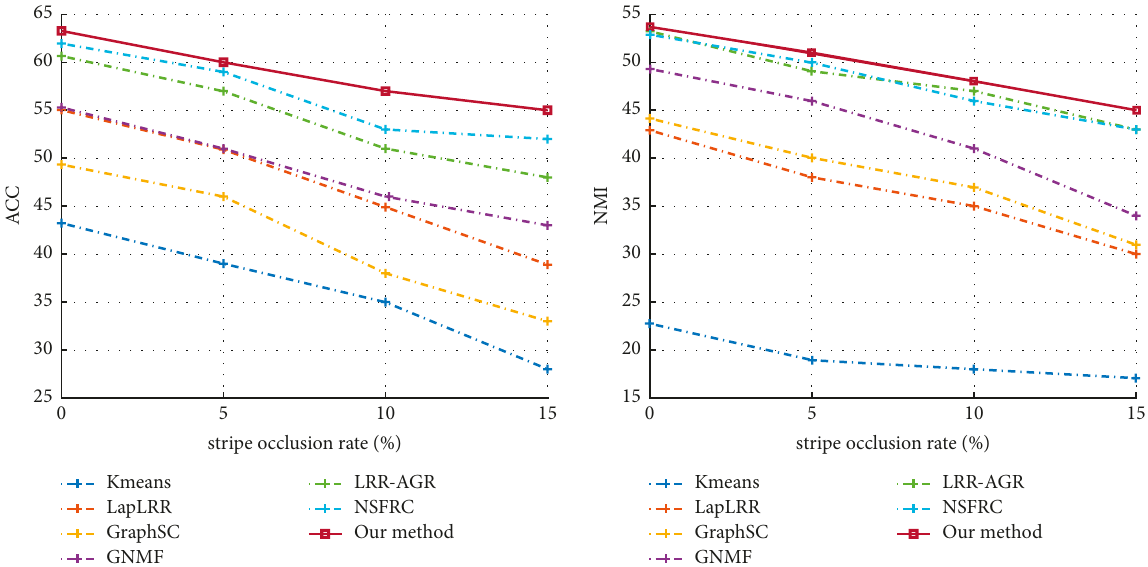
Figure 3: Clustering performances of different algorithm on corrupted FERET dataset.